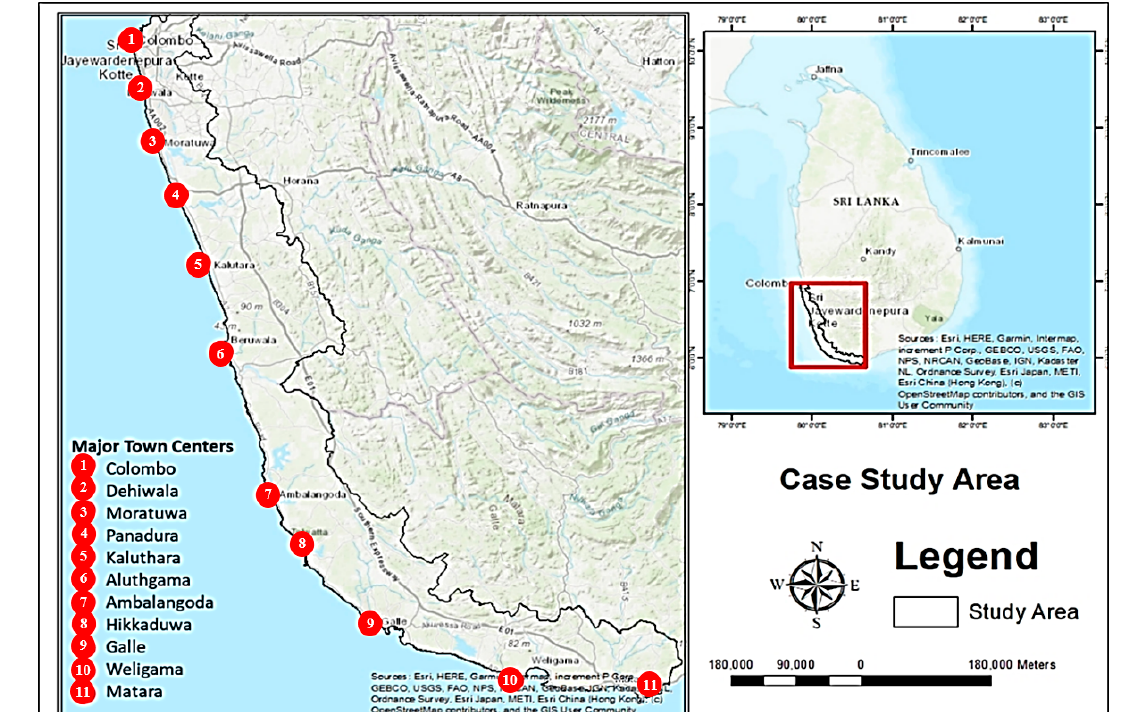
Figure 2. Location of the study area.